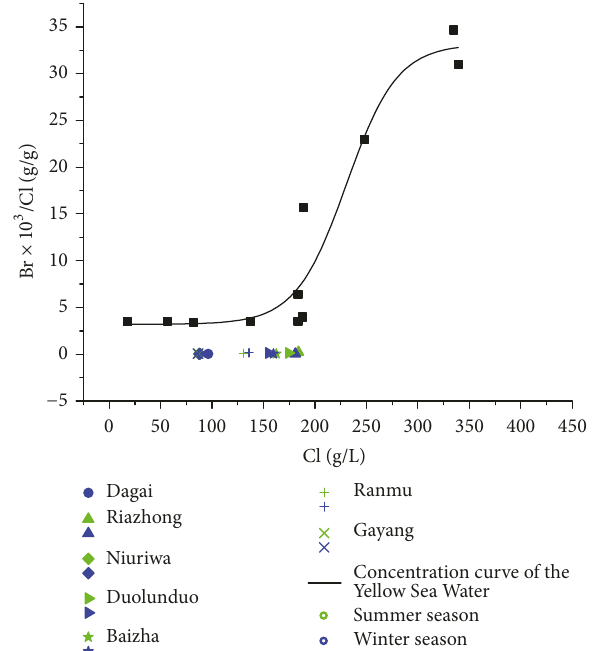
Figure 4: Relationship between Br × 10 3 /Cl and Cl content. Br × 10 3 /Cl of the black points on the concentration curve of water from the Yellow Sea are from Chen [9].